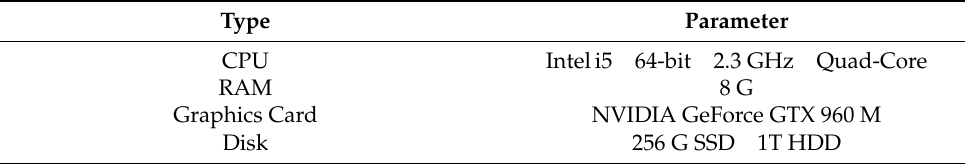
Table 4. Computer hardware parameters.